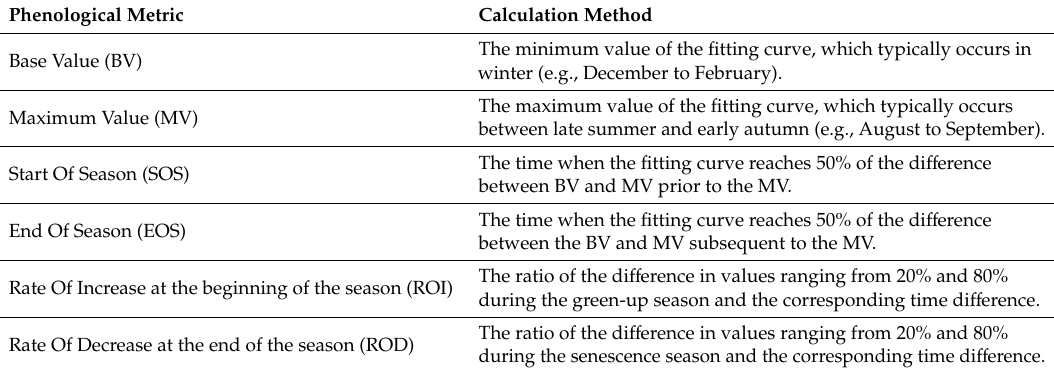
Table 3. Phenological metrics used in our study and their calculation